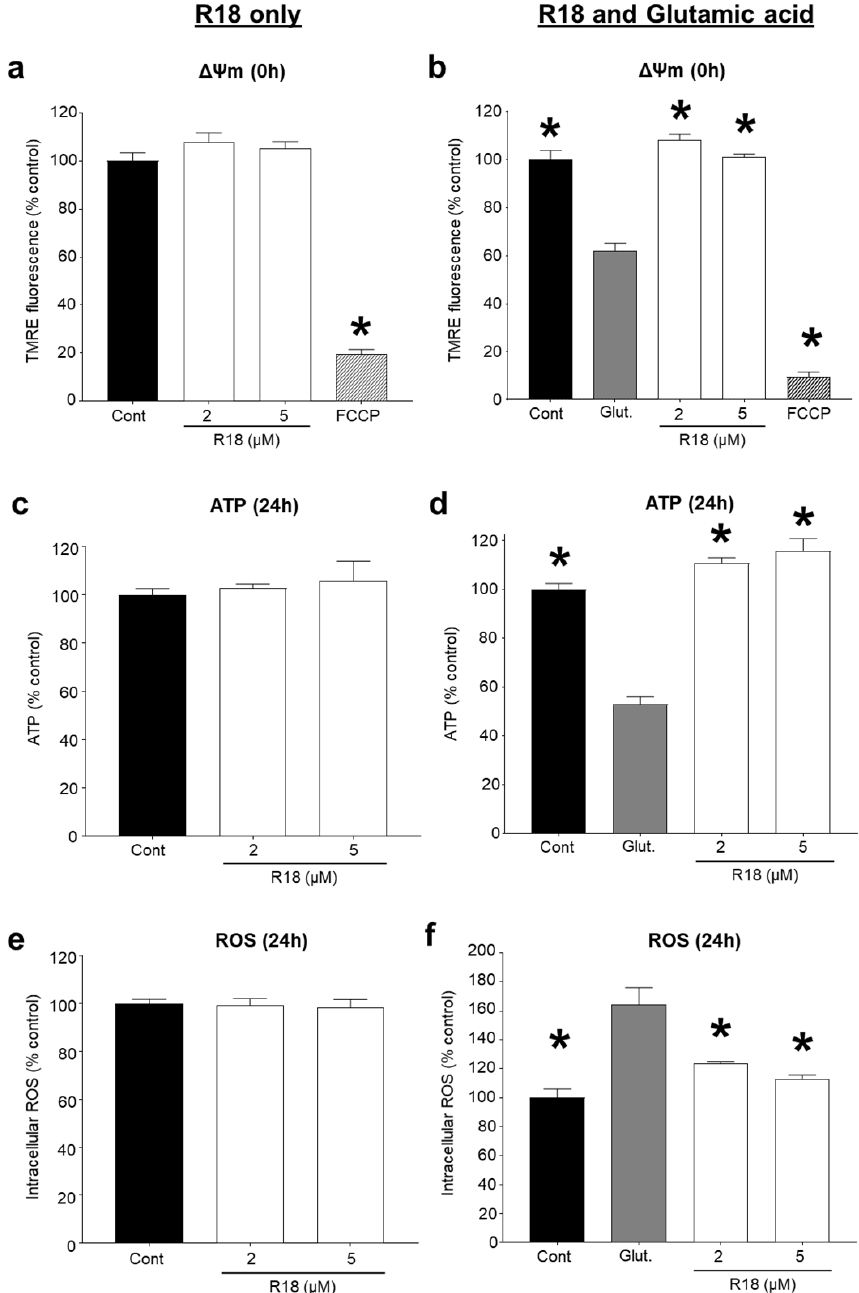
Figure 4. R18 does not disrupt mitochondrial bioenergetics and preserves mitochondrial bioenergetics post-glutamate excitotoxic insult in primary cortical neurons. Cultures received a 5 min glutamate exposure (100 µ M final concentration) following a 10 min pre-treatment with R18 (2 or 5 µ M). Parameters of mitochondrial bioenergetics were measured fluorometrically post-insult and are represented as fold change in fluorescent intensity. ( a , b ) Membrane potential was measured with tetramethylrhodamine ethyl ester (TMRE) immediately post-insult. ( c , d ) ATP production and ( e , f ) were measured at 24 h post-insult. Background fluorescent values were removed, and experiments were conducted at least three times with independent neuronal cultures. Values are means ± SEM; n = 3, with a minimum of eight biological replicates per sample in each experiment; * p < 0.05. FCCP (carbonyl cyanide 4-(trifluoromethoxy)phenylhydrazone; 20 µ M) was used as a positive control for mitochondrial membrane